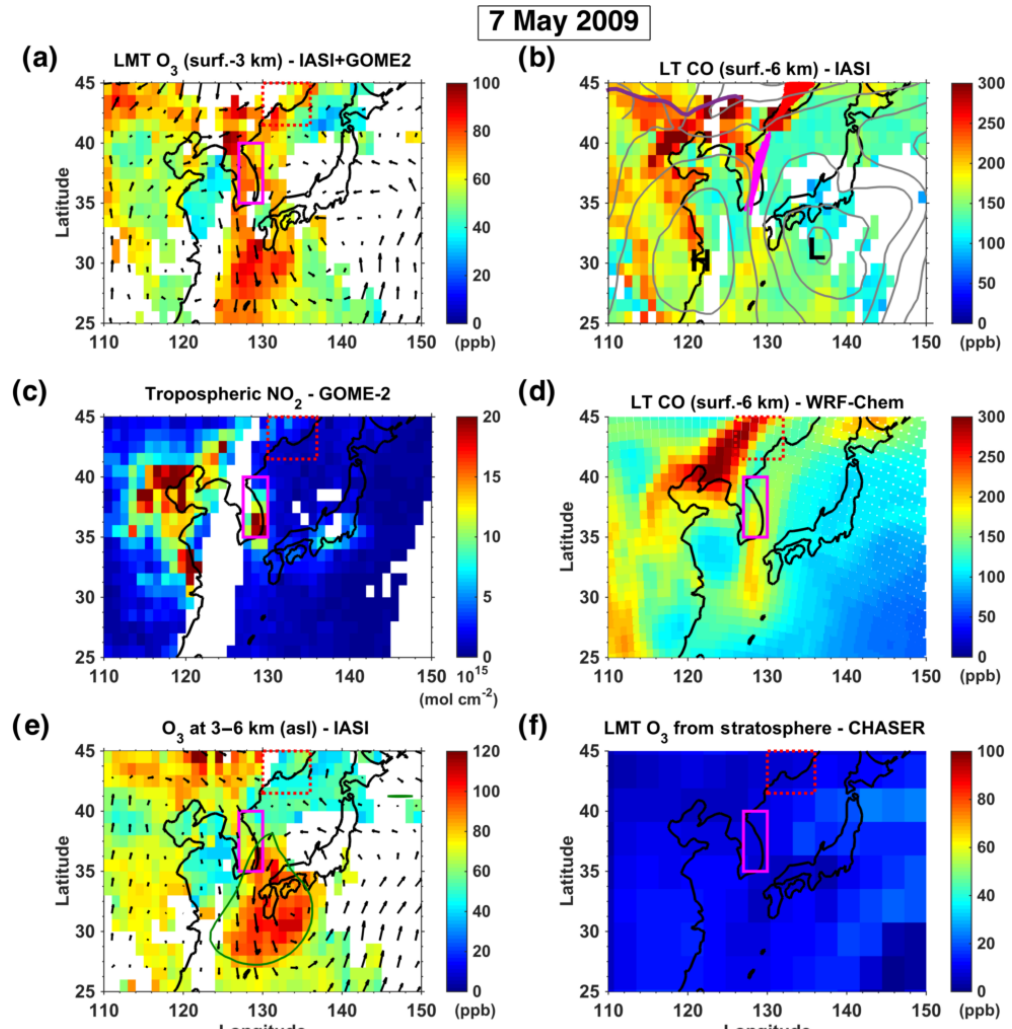
Figure 10. Same as Fig. 7 for panels (a) and (b) but for 7 May 2009. (c) Tropospheric NO 2 distribution derived from GOME-2 measurements. (d) LT CO distribution according to WRF-Chem model. (e) Tropospheric ozone from 3 to 6km altitude derived from IASI, winds at 700hPa and potential vorticity at 300hPa contours (2 PVU in green) from ERA-I. (f) Stratospheric ozone reaching the LMT according to CHASER model simulations. Panel (b) also shows geopotential heights at 850hPa from ERA-I (grey contours every 200m) and the location for 7 May 2009 of the polluted tracked air masses derived from HYSPLIT (magenta and red dots for the southern and northern pollution filaments respectively). For WRF-Chem (d) , the northern pollution plume (dotted red square) is shifted 4 ◦ to the west, in order to account for the difference in its location between the model and satellite observations. The location of a cold front is shown by a violet curve in panel (b)